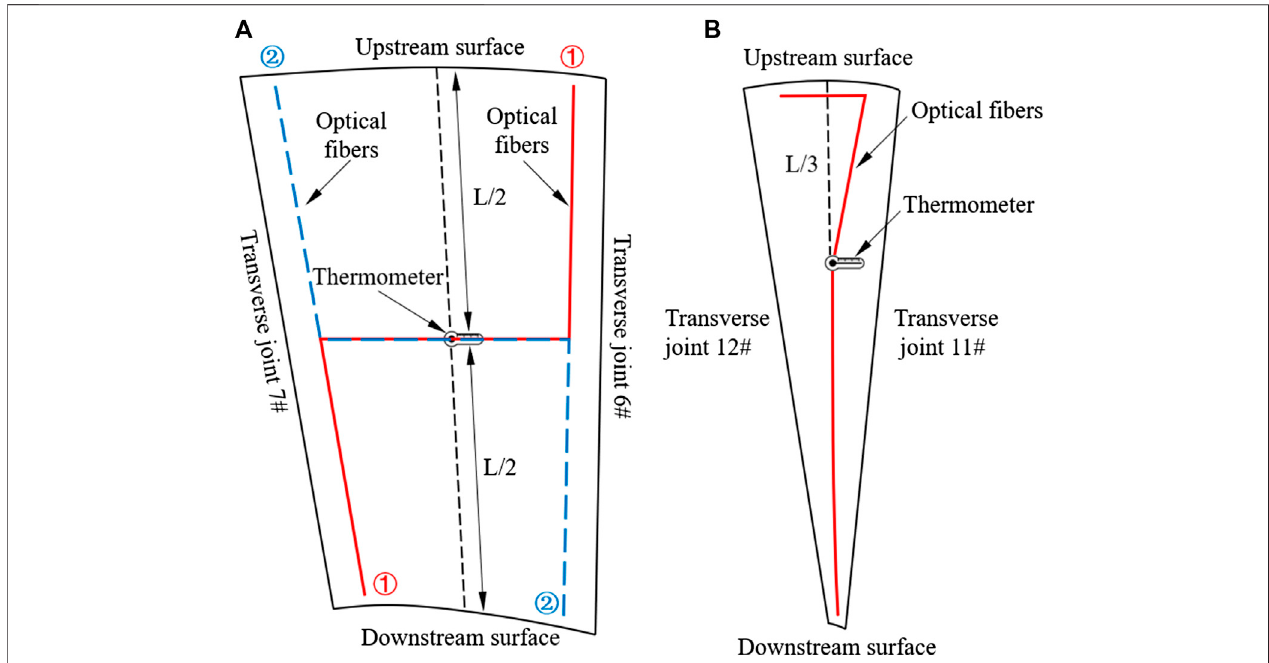
FIGURE 9 | Layout scheme of distributed optical fi bers: (A) in quadrilateral concrete blocks; (B) in triangular concrete blocks.